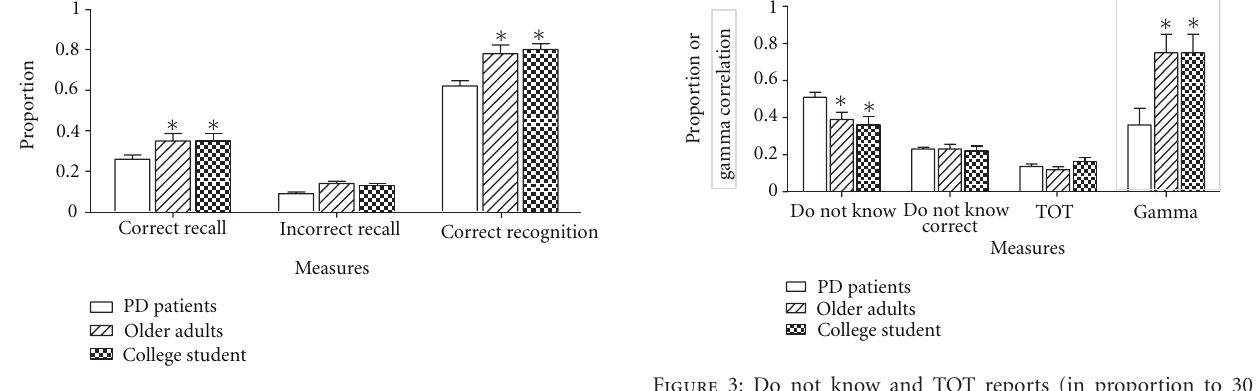
Figure 2: Recall and recognition performance expressed in pro- portion of the total number of general knowledge questions (30 questions) for college students (open bars), older adults (hatched bars), and Parkinson patients (stippled bars). ∗ P < . 05 compared to college students.